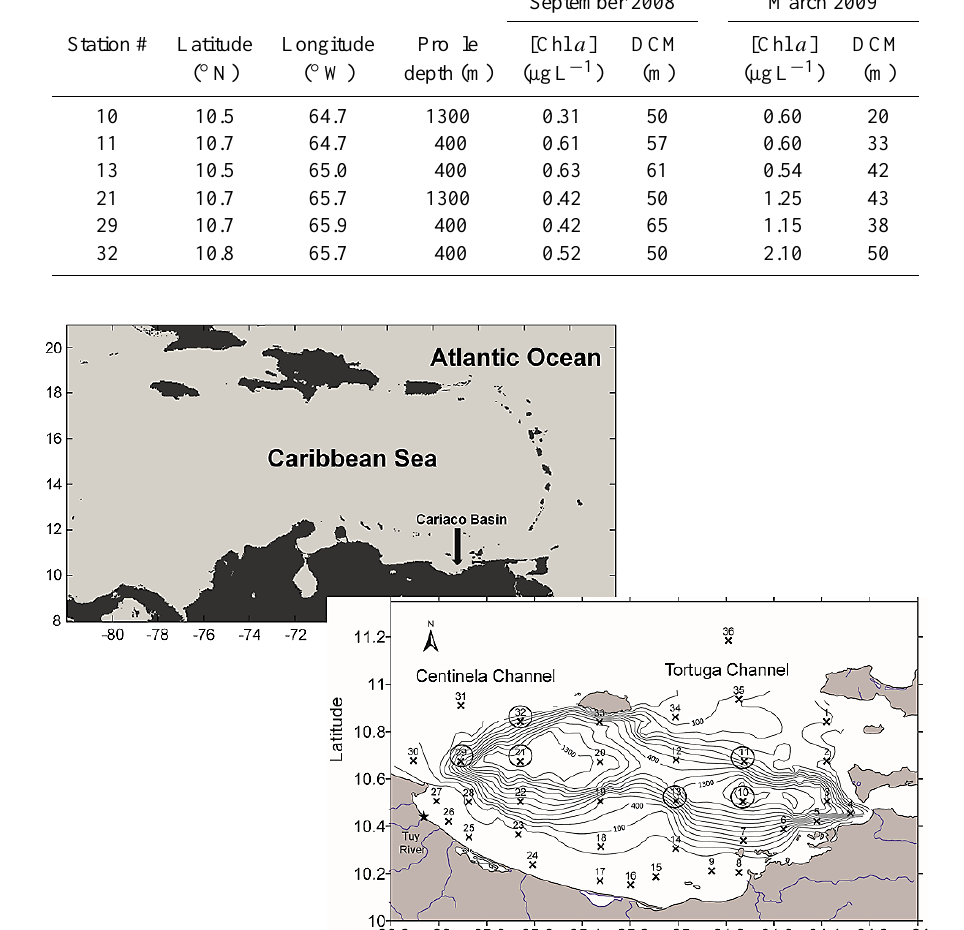
Fig. 1. Location of the Cariaco Basin and stations sampled for N xs to the CARIACO Ocean Time Series Station (10.5 ◦ N, 64.7 ◦ W). Broken lines trace the bathymetry of the basin. The black star shows the location of the Tuy River